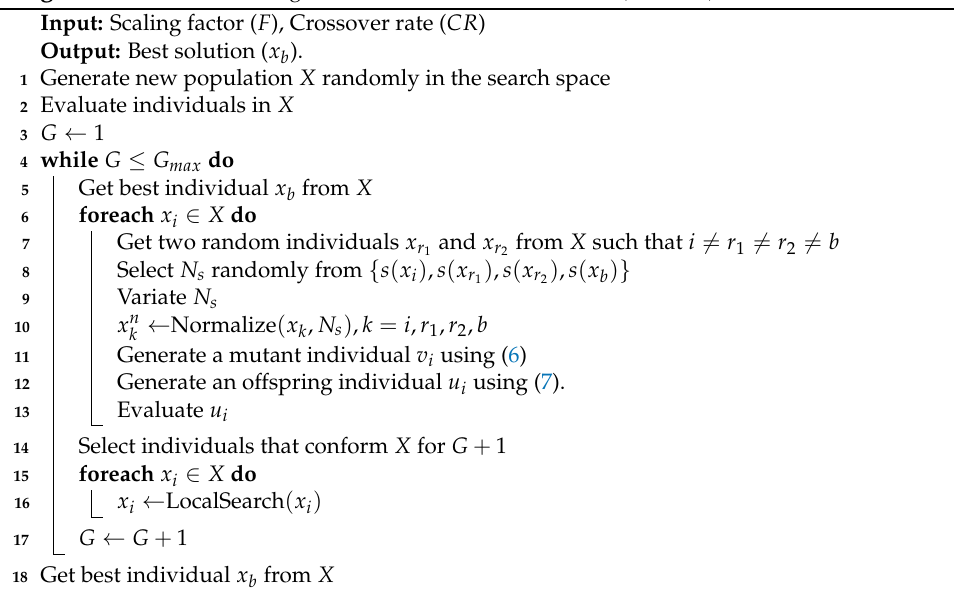
Algorithm 1: Variable-Length-Vector Differential Evolution